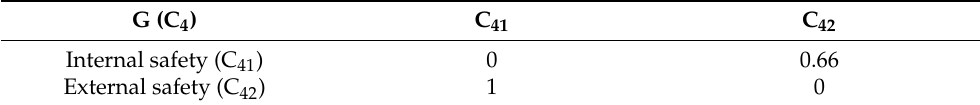
Table 14. Normalized direct influence matrix T between Safety (C 4 ) sub-criteria.